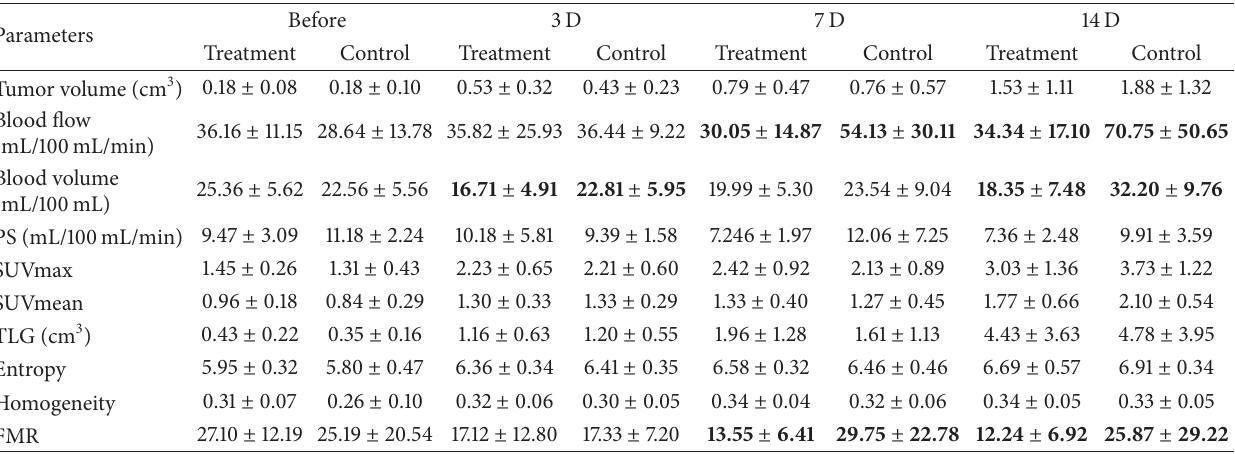
Table 1: Perfusion and metabolic parameters between the treatment and the control groups at each time point. Before 3 D 7D 14D Parameters Treatment Control Treatment Control Treatment Control Treatment Control Tumor volume (cm 3 ) 0.18 ±